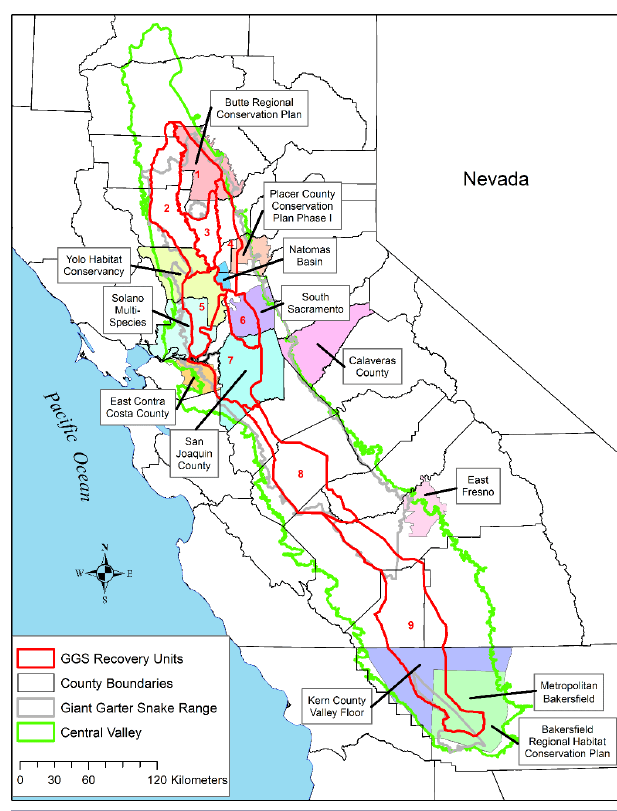
Fig. 2 . Recovery units (numbers correspond to Table 2) for the giant garter snake (GGS; Thamnophis gigas ) and the habitat conservation plan and natural community conservation plan footprints (colored fill) within the Central Valley ecoregion of the state of